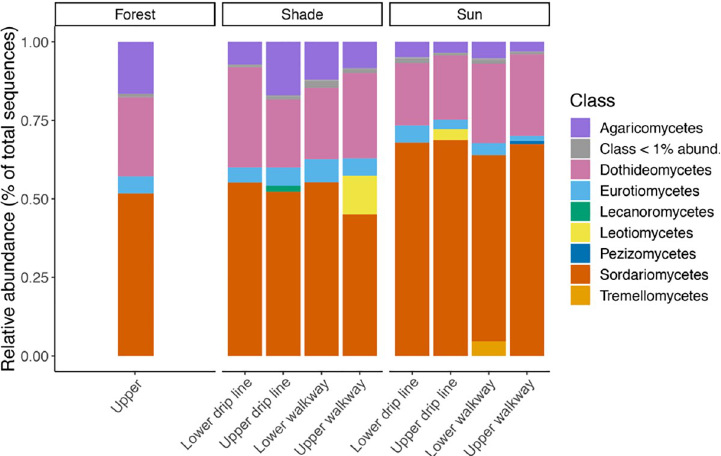
Fig 2. Class abundance of soil fungi across systems, sampling depths, and sampling locations. Eight dominant classes were found within the Ascomycota and Basidiomycota phyla which accounted for 97.2% relative abundance of the total sequences